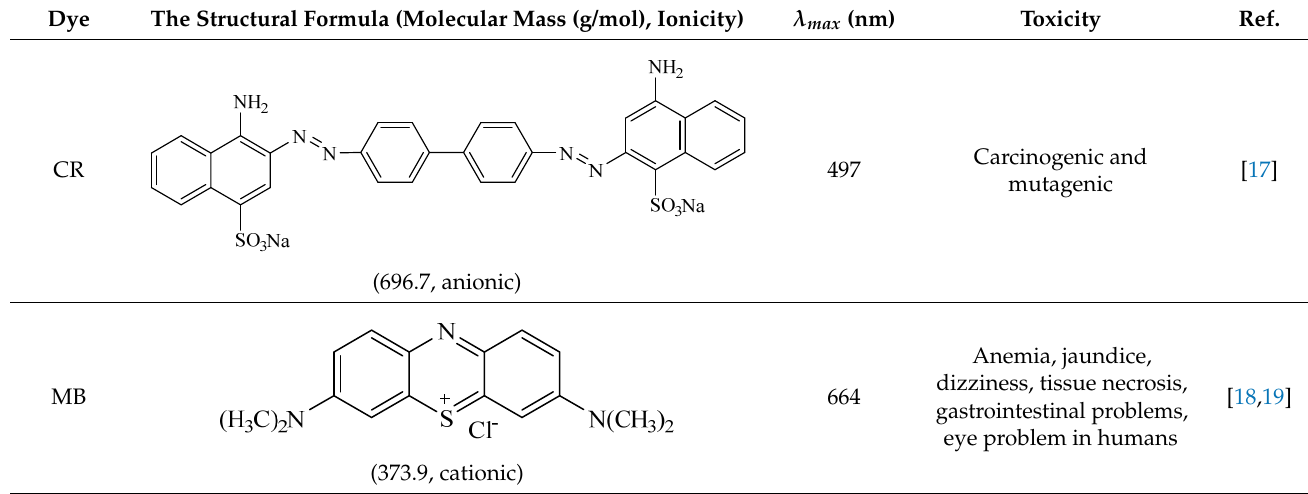
Table 1. Structural formula, maximum UV-vis absorption ( λ max ), and toxicity of CR and MB dyes. Dye The structural formula (molecular mass (g/mol), ionicity) λ max (nm) Toxicity Ref.